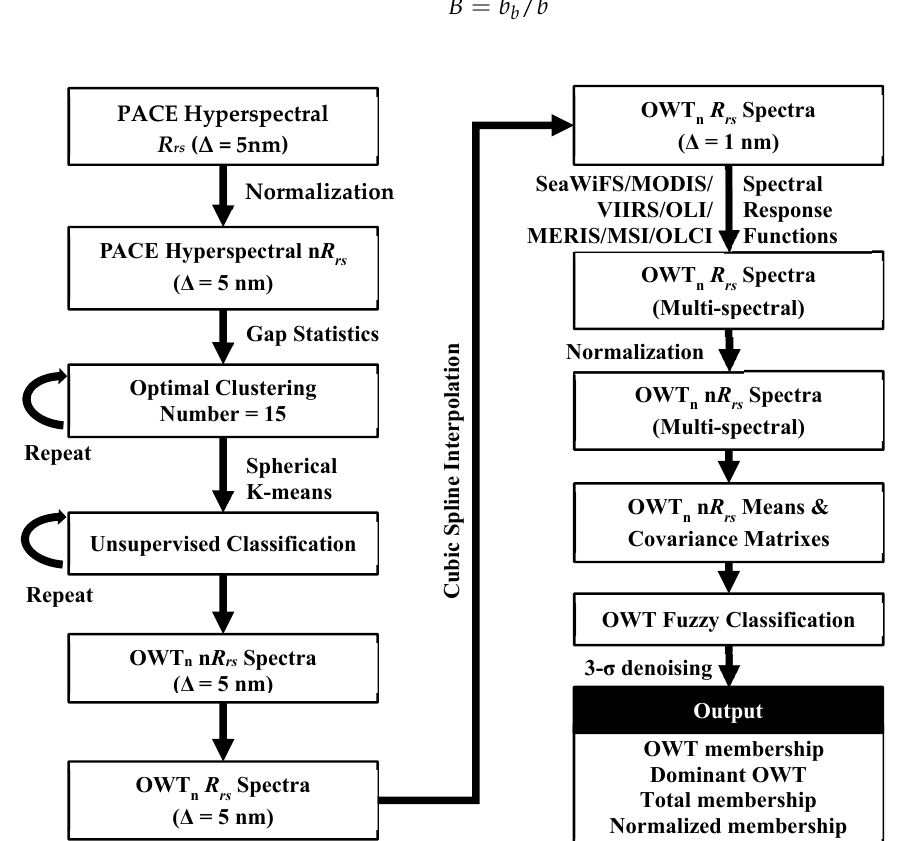
Figure 1. Workflow of the U-OWT development. Table 1. Introduction to different AOP-based water classification